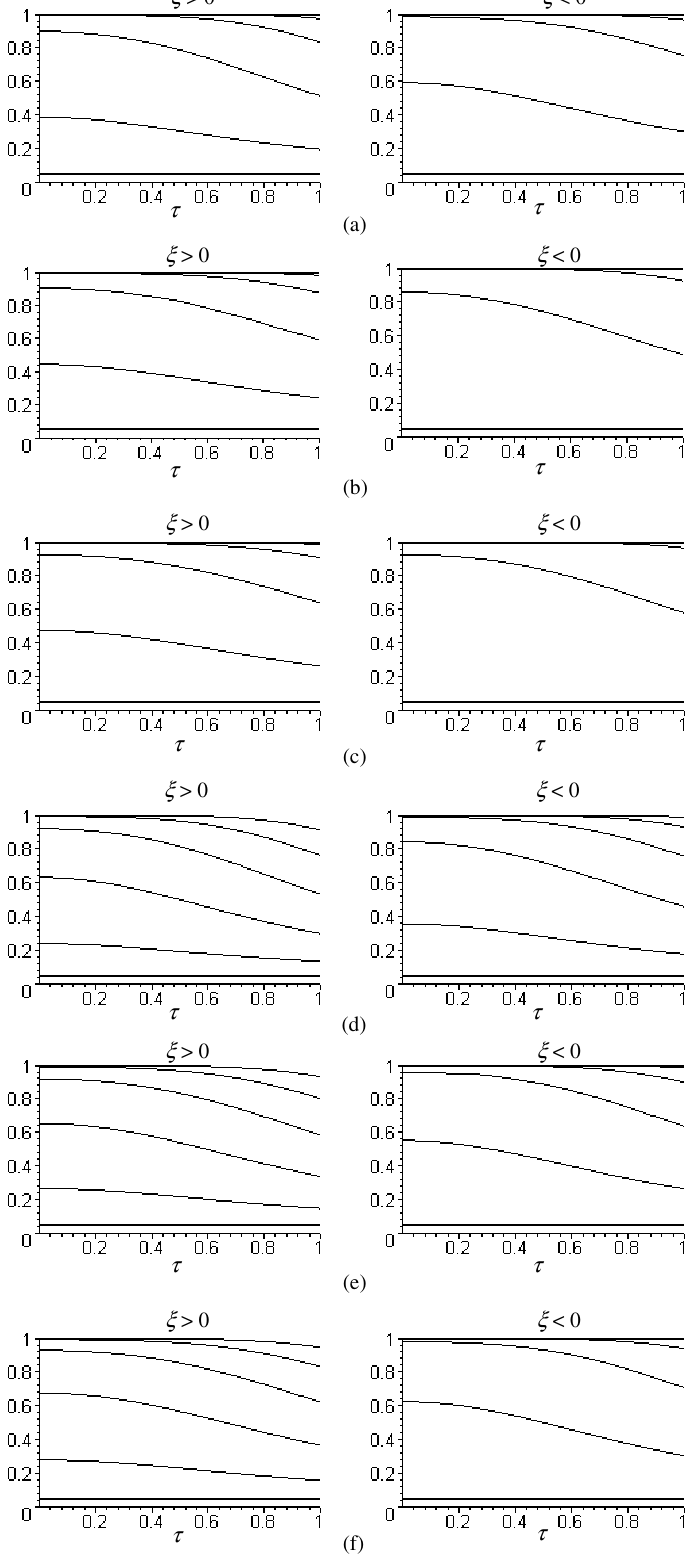
Fig. 3. Plots of π A versus τ with u = 0 . 5, v = 1 . 5, k = 3, n = 50, α = 0 . 05, C u p ( u, v ) = c (0 . 20)( c + 1) (bottom to top) for (a) c = 1 and C u C u u, v ); (b) c = 1 and C u p = p ( (e) c = 1 . 5 and C u p = C u p ( u, v )+ 0.33; (f) c = 1 . 5 and C u p = C u p ( u, v ) + 0 .